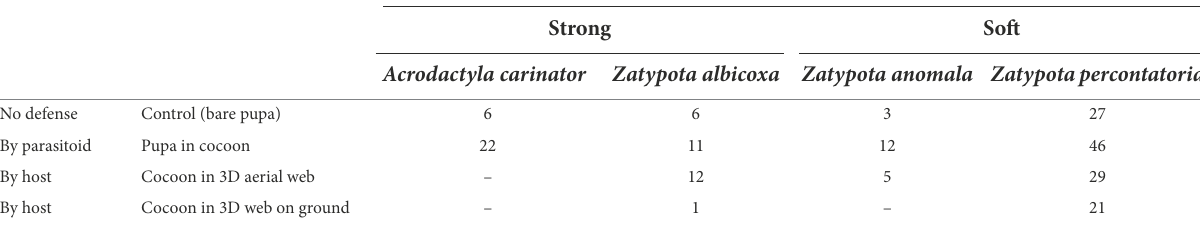
TABLE 1 Number of pupa individuals used in various